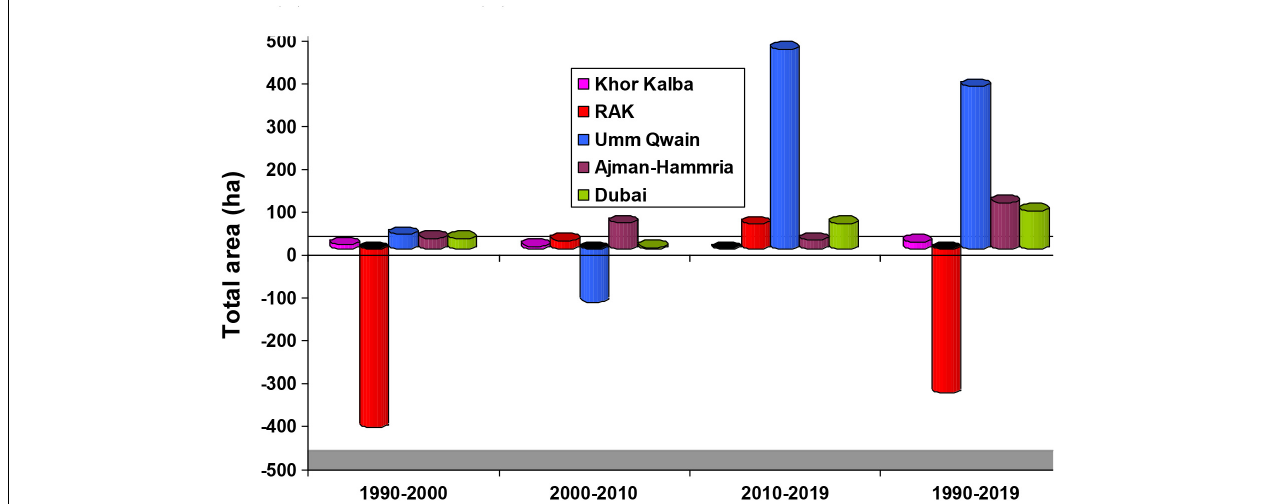
FIGURE 17 | The graphical representation of the NUAE mangrove forests extent from 1990 to 2019 (in hectare). The graph shows a significant decrease in RAK Mangroves from 1990 to 2000 (in hectare) and a slight decrease in Umm Al Quwain Mangroves from 2000 to